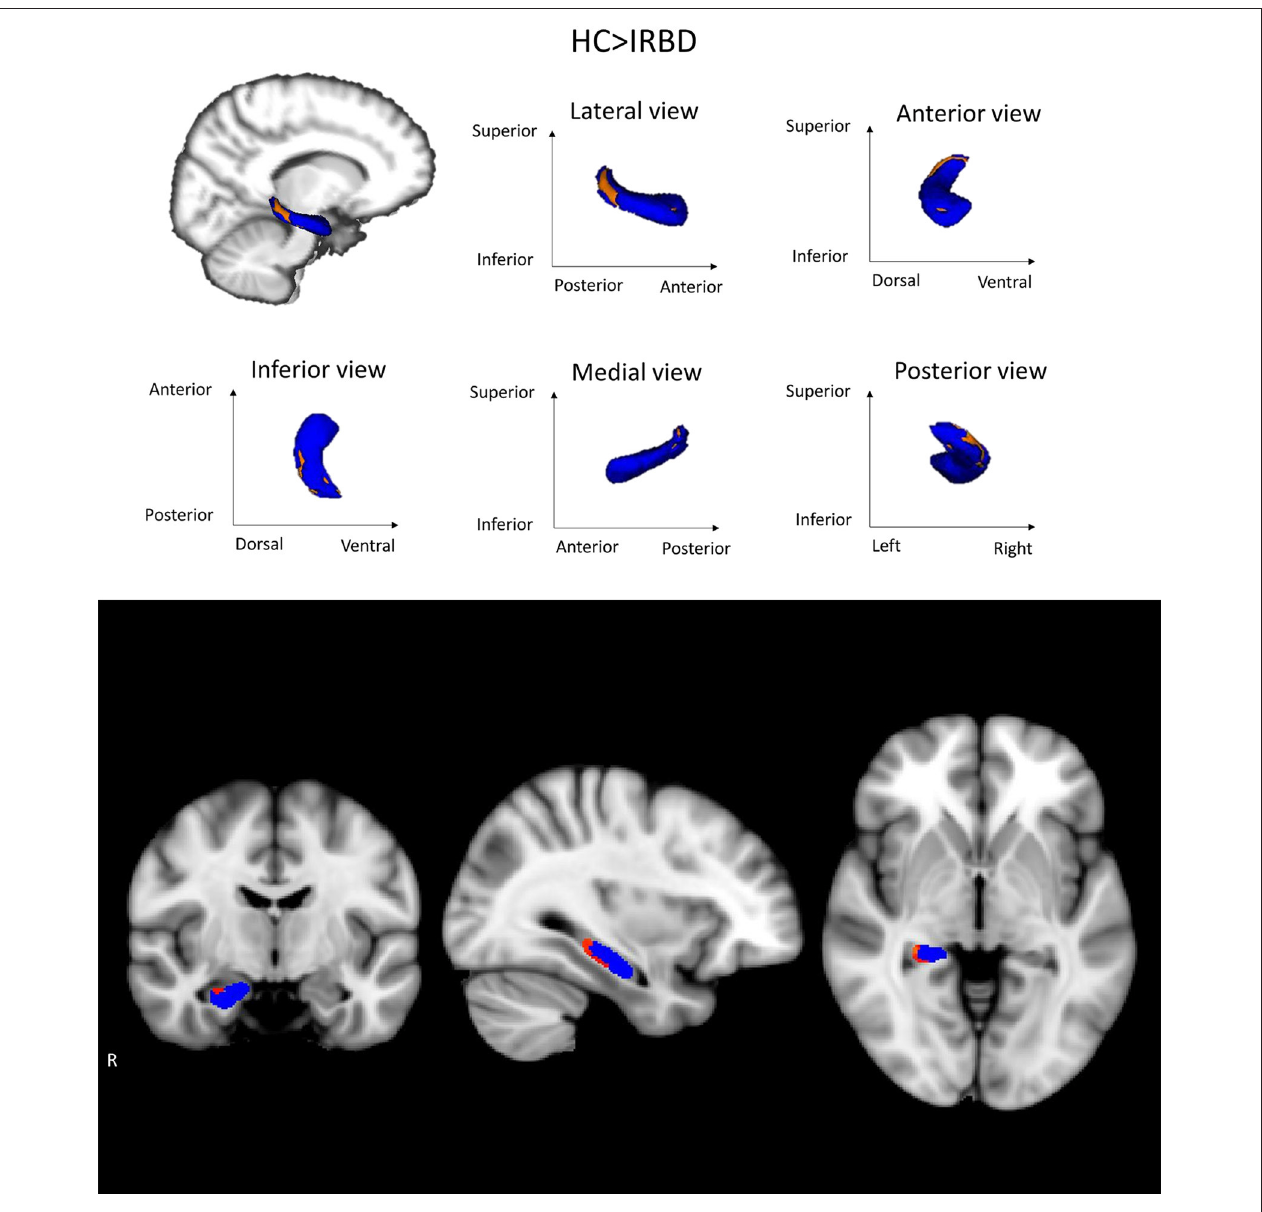
FIGURE 2 | Hippocampal shape differences between HC and IRBD patients. Images show right hippocampus shape differences between HC and IRBD patients when age and estimated Total Intracranial Volume were introduced as covariates. Significant clusters of shape differences (local atrophy) between the groups are highlighted in warm colors (corrected P < 0.05). Results are overlaid on the right hippocampus mask (blue) and displayed over the sagittal, coronal and axial sections of the MNI standard brain. Graphics Program: fslview from FSL (https://fsl.fmrib.ox.ac.uk/fsl/fslwiki/FslView/UserGuide) and edited with Microsoft PowerPoint ®